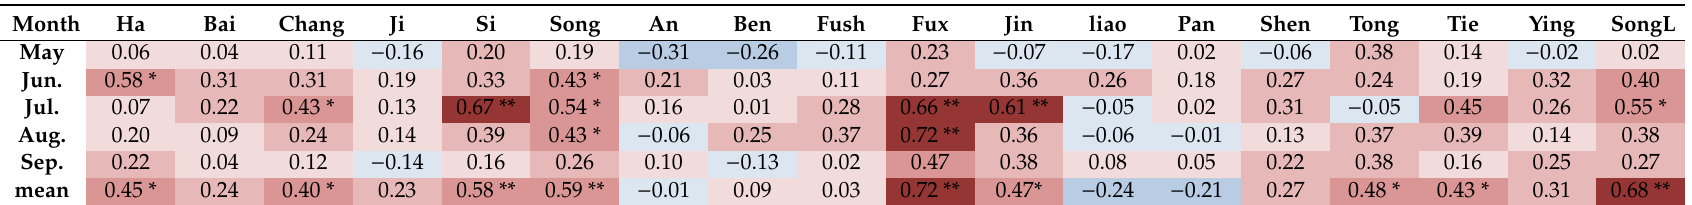
Table 4. Pearson’s correlation coe ffi cient of SPEI-1 and climate yield in the maize growing season in the Songliao Plain maize belt during the period 1998–2017. Month Ha